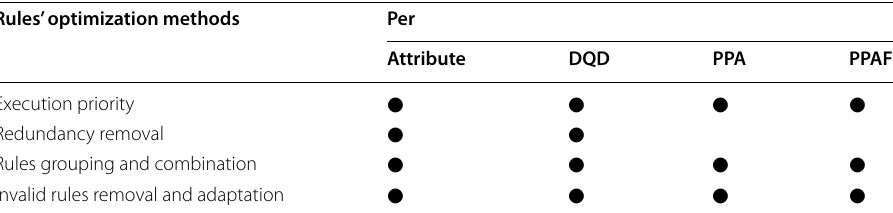
PP Pre-processing, PPA Pre-processing activity, PPAF Pre-Processing activity function